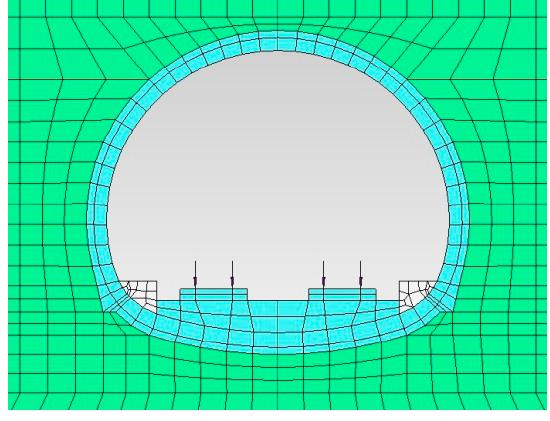
Figure 3. Mesh grid.